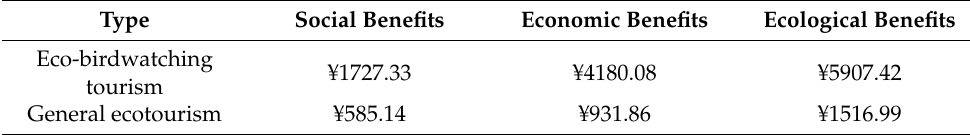
Table 5. Annual social, economic, and ecological benefits achieved per capita by ecotourism.